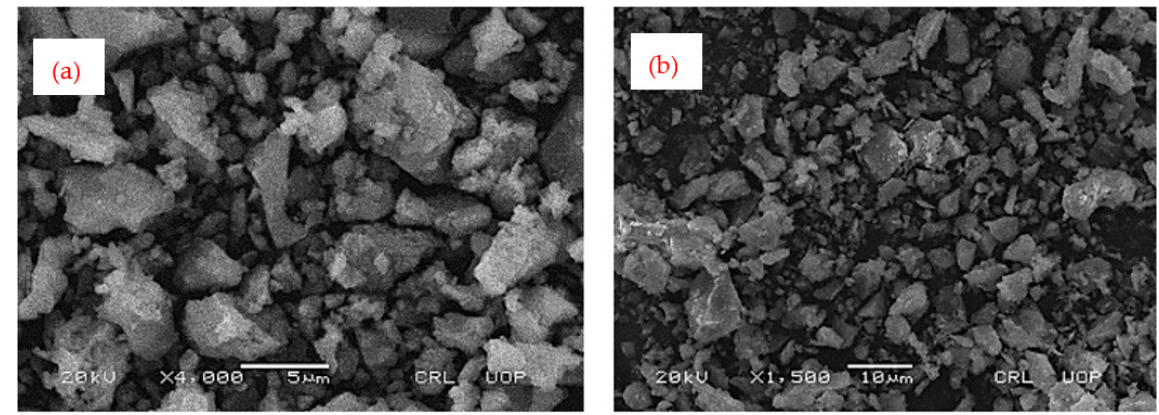
Figure 5. Scanning electron microscopy images of waste burnt brick powder: ( a ) at 5 µ m resolution; ( b ) at 10 µ m resolution.